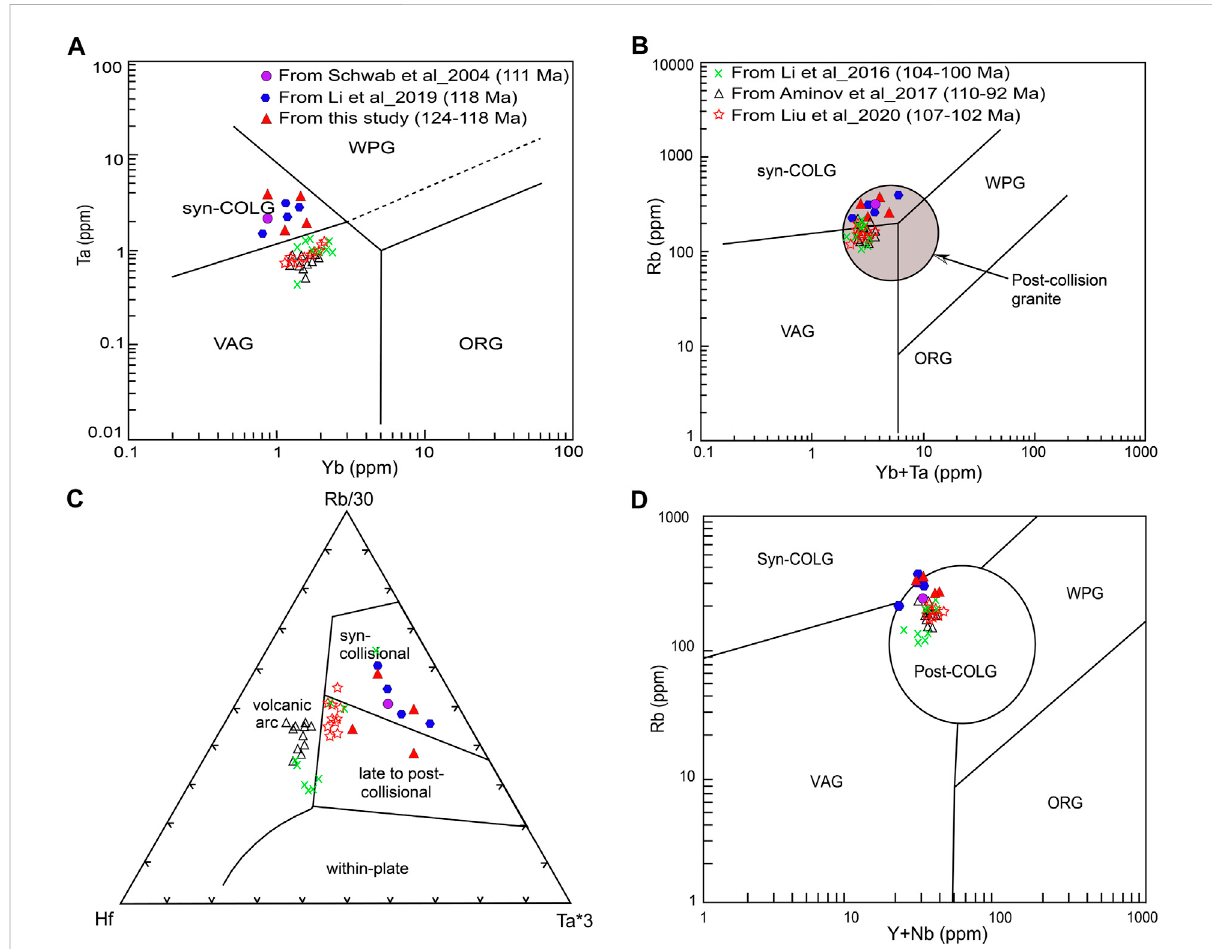
FIGURE 11 Trace element geotectonic discrimination diagrams. (A) Ta vs. Yb, (B) Rb vs. (Yb+Ta), (C) Hf-Ta*3-Rb/30, and (D) Rb vs. (Y+Nb) (after Pearce (1996)andHarrisetal.(1986)).Abbreviations:WPG,within-plategranites;synCOLG,syn-collisionalgranites;VAG,volcanicarcgranites;ORG,ocean ridge granites. The reference data are compiled from Schwab et al. (2004); Li et al. (2016); Aminov et al. (2017); Li R. H. et al. (2019) and Liu et al.